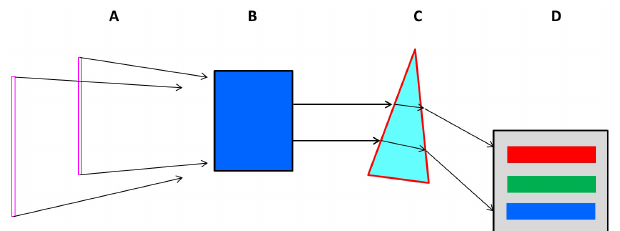
Figure 11. The principal design of a spectrometer that has multiple slits (A), a collimator (B), a prism (C), and a single two-dimensional detector array (matrix D). The spectrometer merges the light from all the slits together, but since the Earth always occupies only one slit, the signals from different slits do not interfere with each